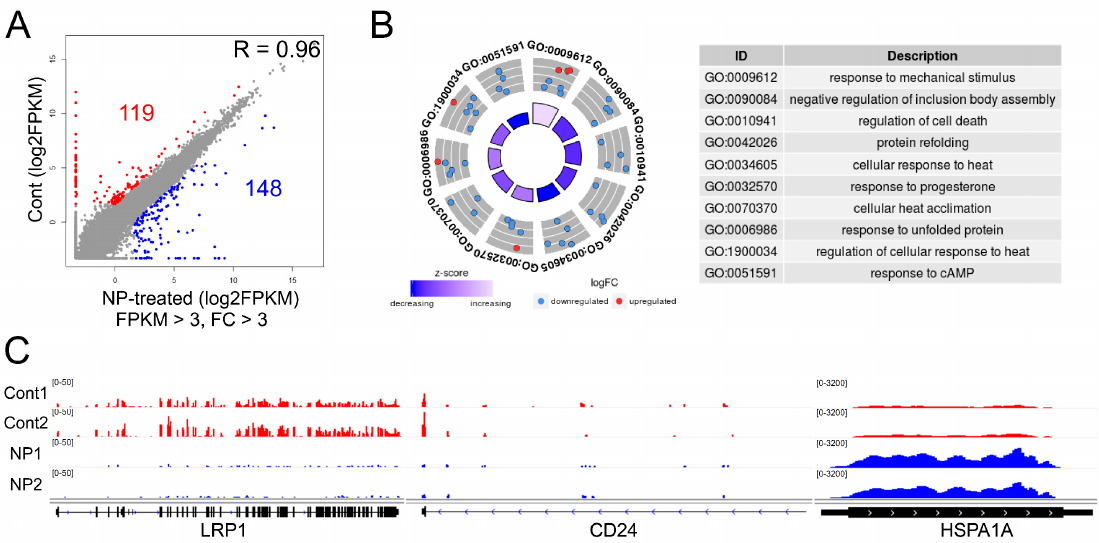
Figure 8. Graphene oxide alters gene expression patterns. ( A ) Scatterplot showing differentially expressed genes (DEGs) in RGO-exposed HEK293 cells. Red and blue dots represent genes respectively down- and upregulated in the experimental group. Log 2 FPKM values were used for plotting. Cutoff values: FPKM > 3 and fold change (FC) > 3. ( B ) GO term analysis of the DEGs. ( C ) IGV browser images of representative down- ( LRP1 and CD24 ) and upregulated ( HSPA1A ) genes.